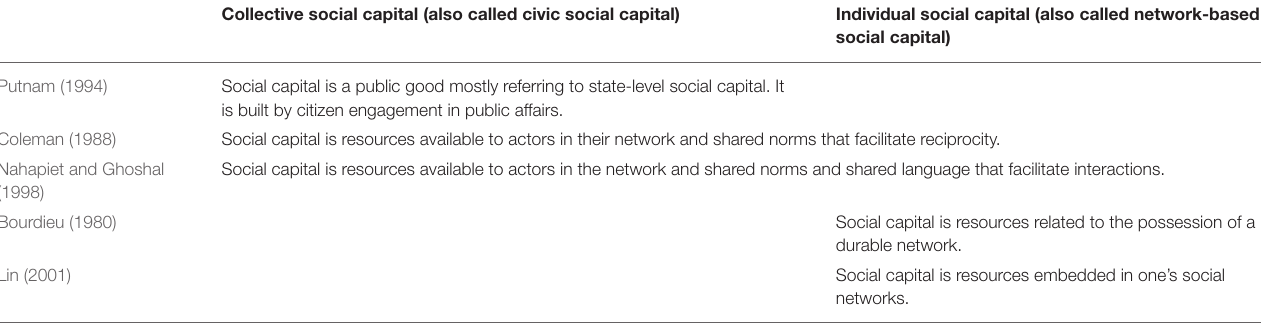
TABLE 1 | Different conceptualizations of social capital (table inspired by Claridge, 2018). Collective social capital (also called civic social